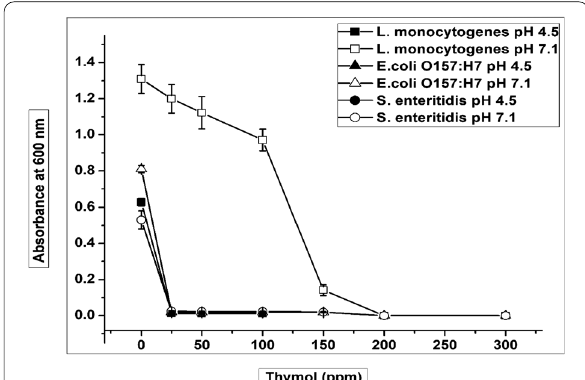
Fig. 1 The Influence of different pH values on bactericidal activity of Thymol against E.coli O157: H7, S. enteritidis , and L. monocytogenes . Thymol concentrations (0, 50, 100, 150, 200, 250 and 300) ppm were each added to 10 ml tryptone soya broth tubes, and then inoculated (50 μl) of an overnight culture of bacterial suspension (O.D 600 1.818). Tubes were incubated at 37 °C for 24 h. Negative and positive controls were performed. The optical density of each tube was measured using a spectrophotometer. Data are shown as a mean of two independent experiments with standard error ( P < 0.05)